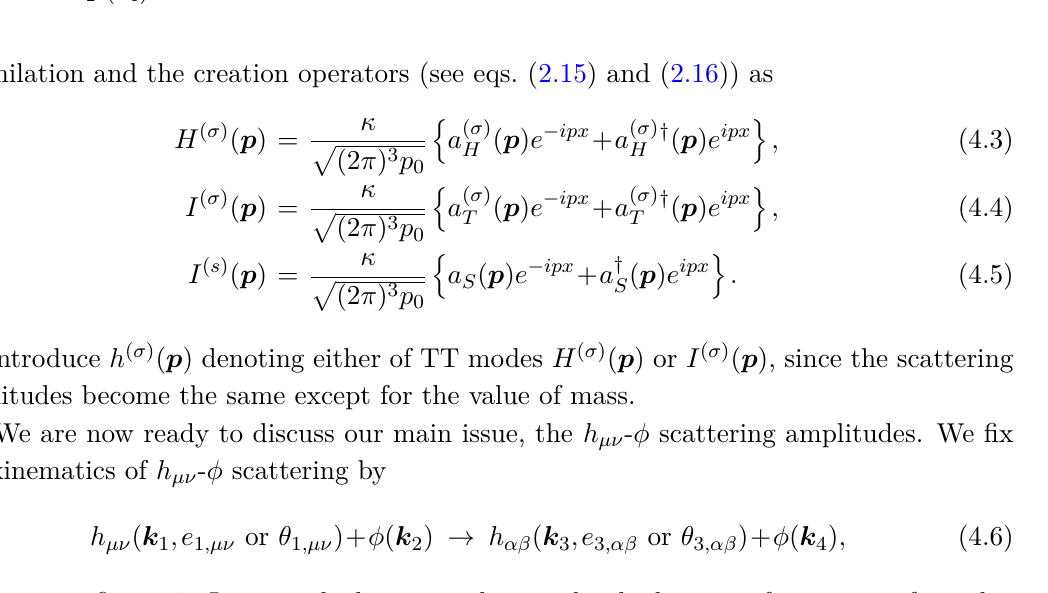
Figure 3 . Contact, s -, u - and t -channel exchange diagrams (from left to right): the double wiggly lines correspond to graviton h µν , while the scalar field φ is described by dotted lines. The initial (final) state is composed of a graviton h µν ( h αβ ) with momentum k 1 ( k 3 ) and a scalar field φ with momentum k 2 ( k 4